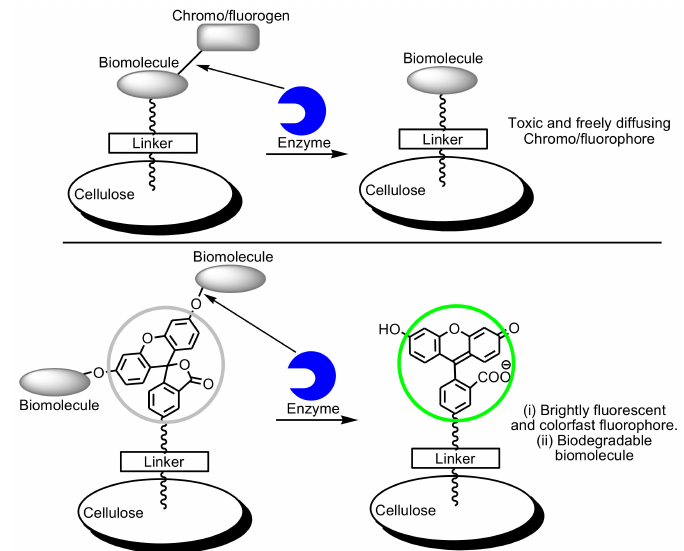
Figure 5. Cellulose-based enzyme biosensor comprising a surface linked with biomolecules ( top ), and a surface linked with fluorogenic moiety ( bottom